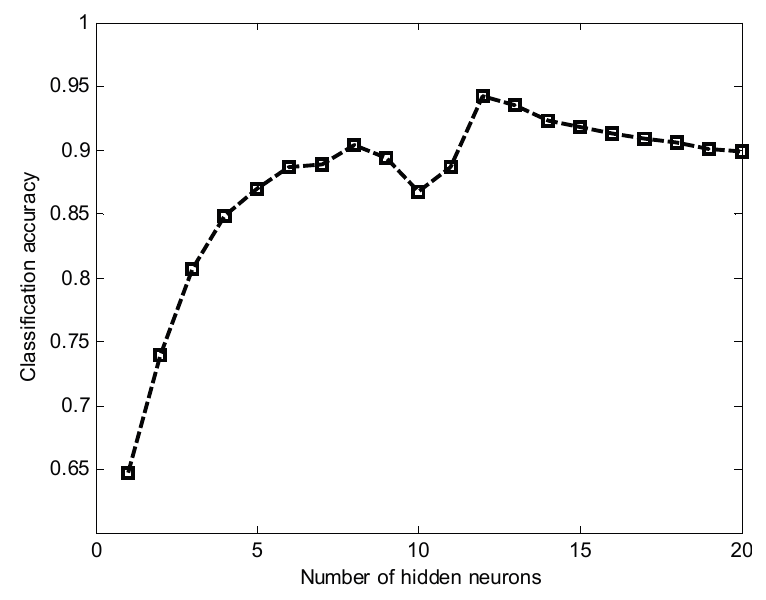
Figure 4. Classification accuracy for different number of hidden